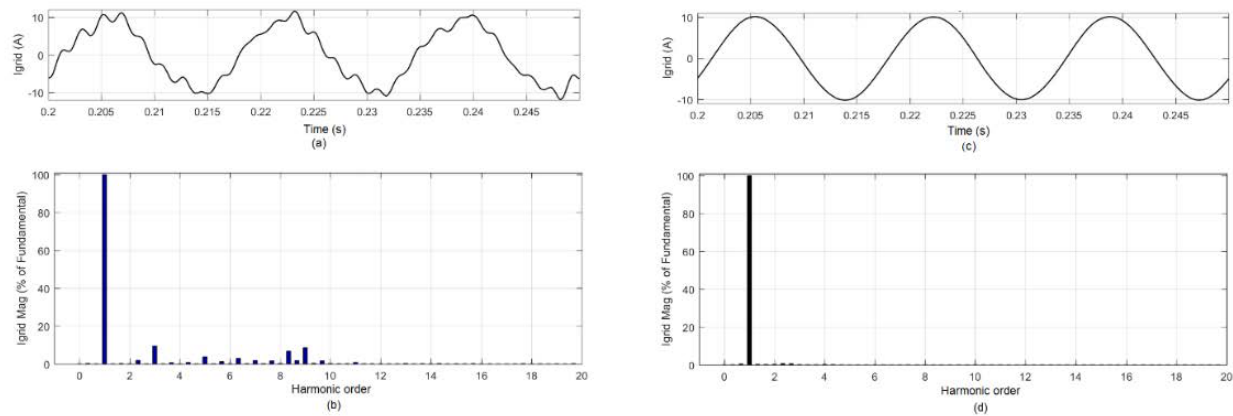
Figure 4. The grid phase-current waveform and the harmonics contents ( a , b ) without control and ( d , c ) with the invariant set controller.